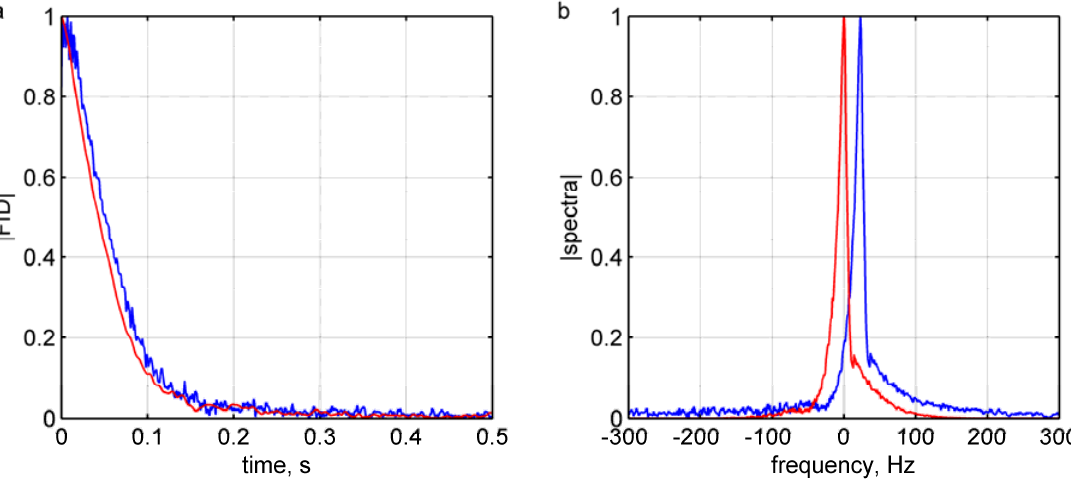
Figure 1. Spectral processing of the single voxel spectroscopic data. ( a ) Raw (blue) and processed (red) magnitude free induction decay functions (FIDs); ( b ) Raw (blue) and processed (red) magnitude spectra. Note that graphics and spectra were normalized to their maximum values for comparison purposes and the panels are scaled